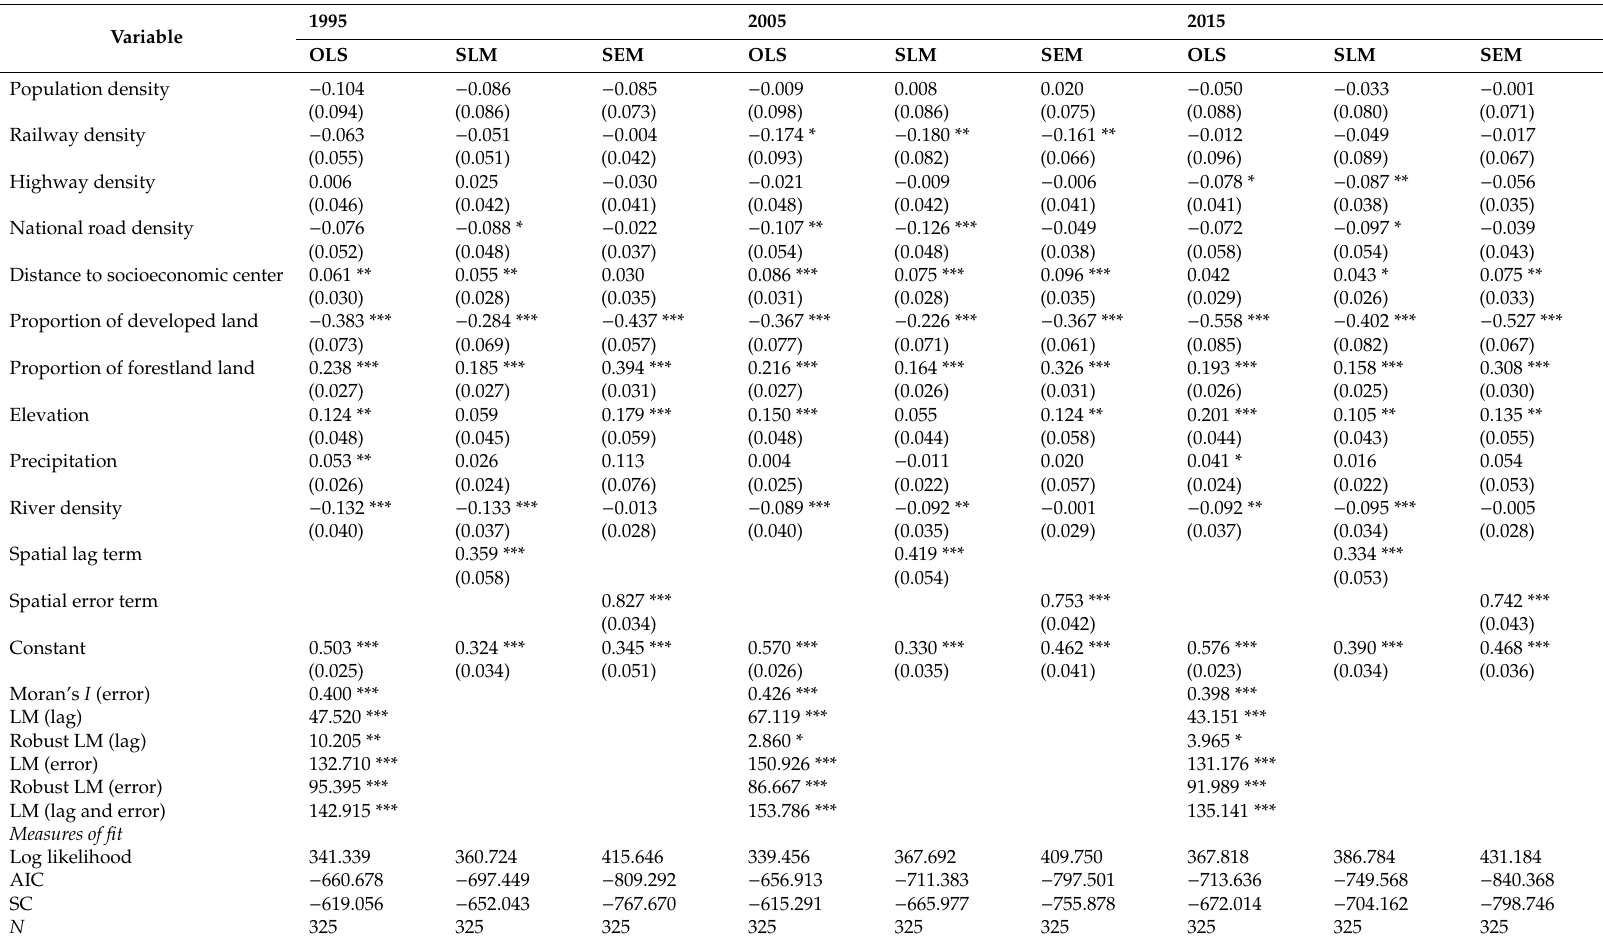
Table 5. Regression results of the ordinary least squares (OLS), spatial lag model (SLM), and spatial error model (SEM) from 1995 to